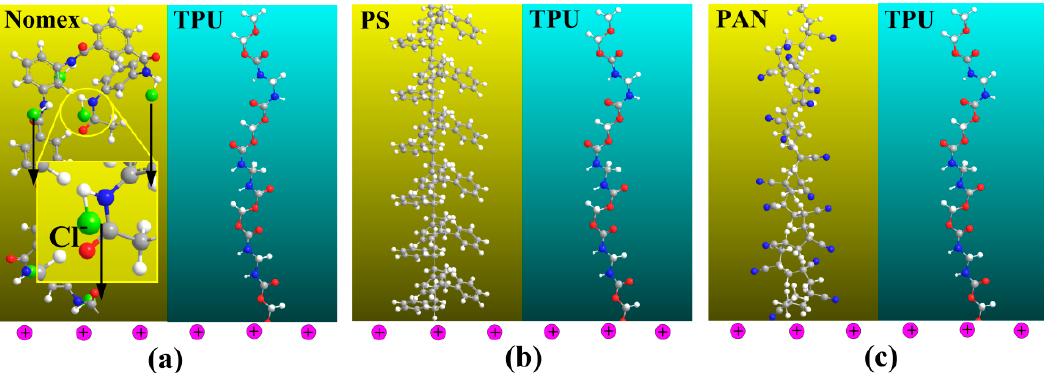
Figure 6. Schematic illustration of attraction force exerted on three polymer systems ( a ) Nomex/TPU, ( b ) PS/TPU, and ( c ) PAN/TPU [15].